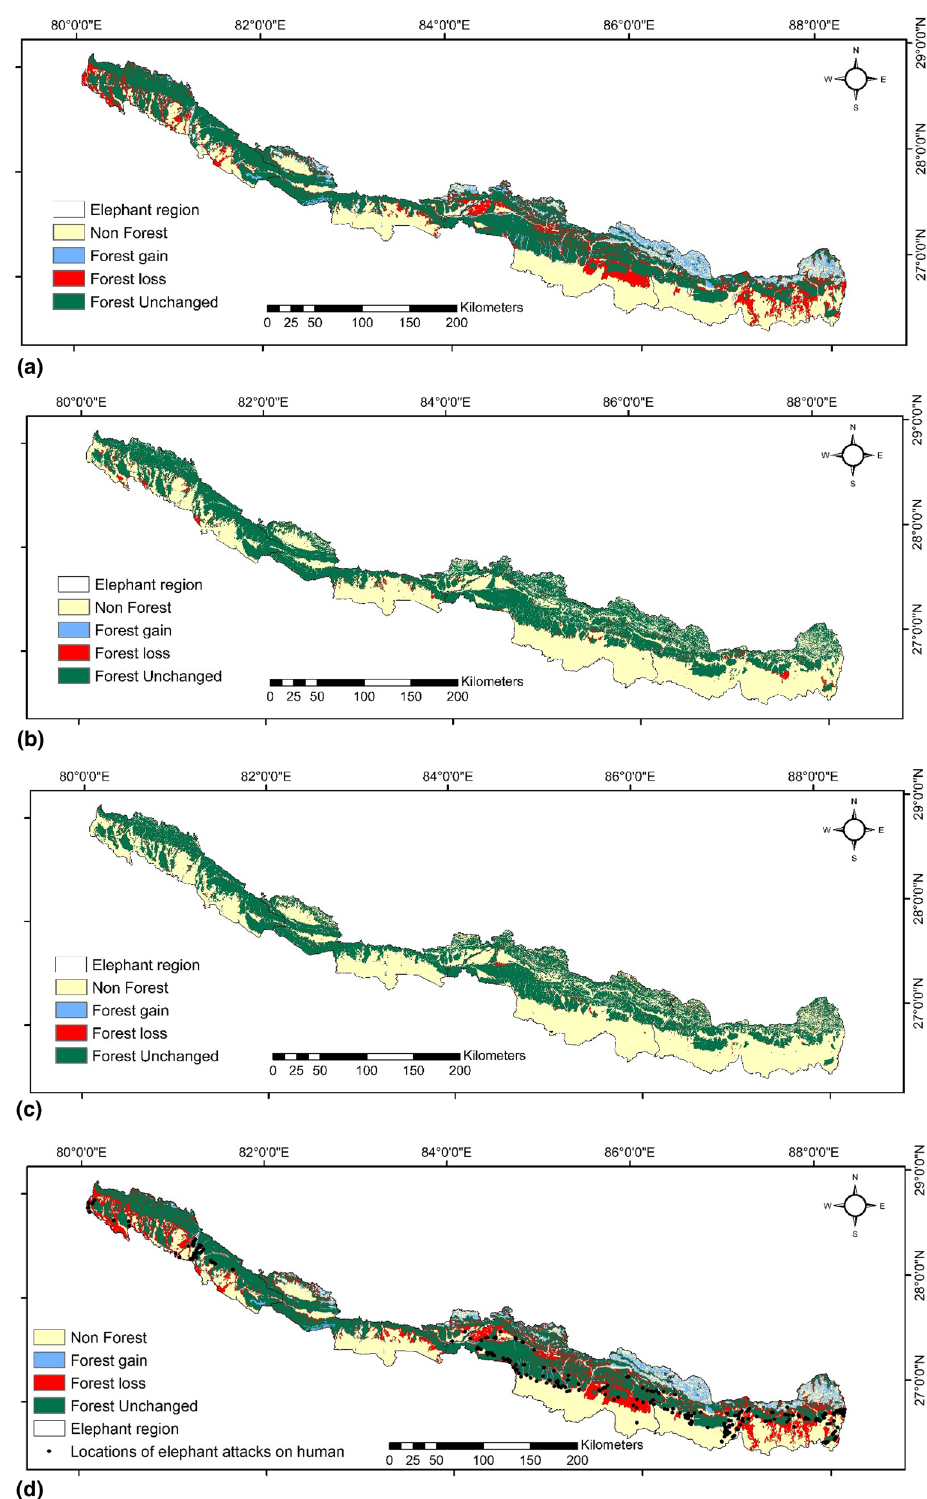
Figure 1. Forest cover change in the Asian elephant habitat (the Chure Terai Madhesh Landscape), Nepal during the time periods ( a ) 1930–1975, ( b ) 1975–2000, ( c ) 2000–2020 and ( d ) 1930–2020. In the map of ( d ) 1930–2020, locations of elephant attacks on humans based on Ram et al. 38 is also overlaid. Map generated by Ashok Kumar Ram using ArcGIS 10.5 101